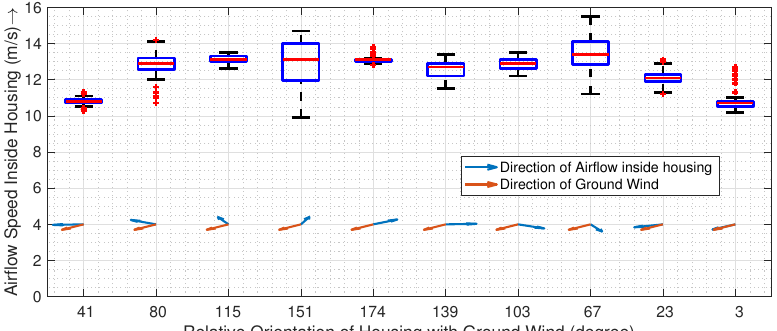
Figure 6. The plot shows a sensitivity in the airflow speed inside the housing in the presence of wind for 10 consecutive flights at different orientations of the UAS from the north at a ground wind speed of 6 mph from the northeast. The box plot captures the 25th to 75th percentile of data, while the central red line indicates the median. The black whiskers and the red plus signs indicate the extreme range and outliers